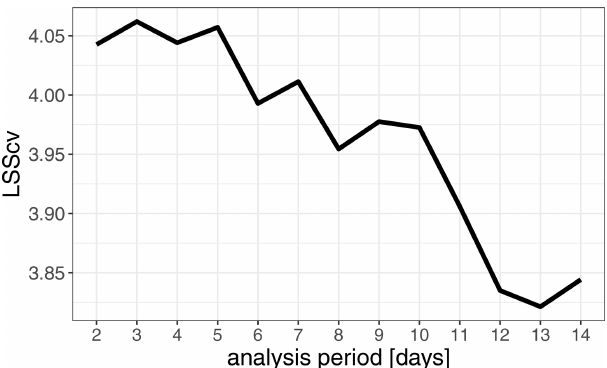
Figure 5. Dependence of the cross-validated logarithmic skill score on the accumulation period of D